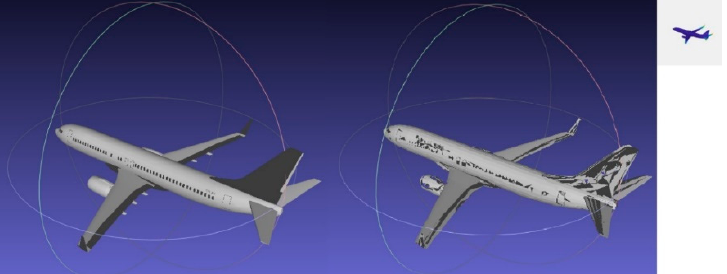
Figure 9. The original model with 113,588 vertices on the left. The re-mesh model with 3388 vertices on the middle. The 2D-projection of the re-mesh model after calculating WKS value on the right. Electronics 2019 , 8 , x FOR PEER REVIEW